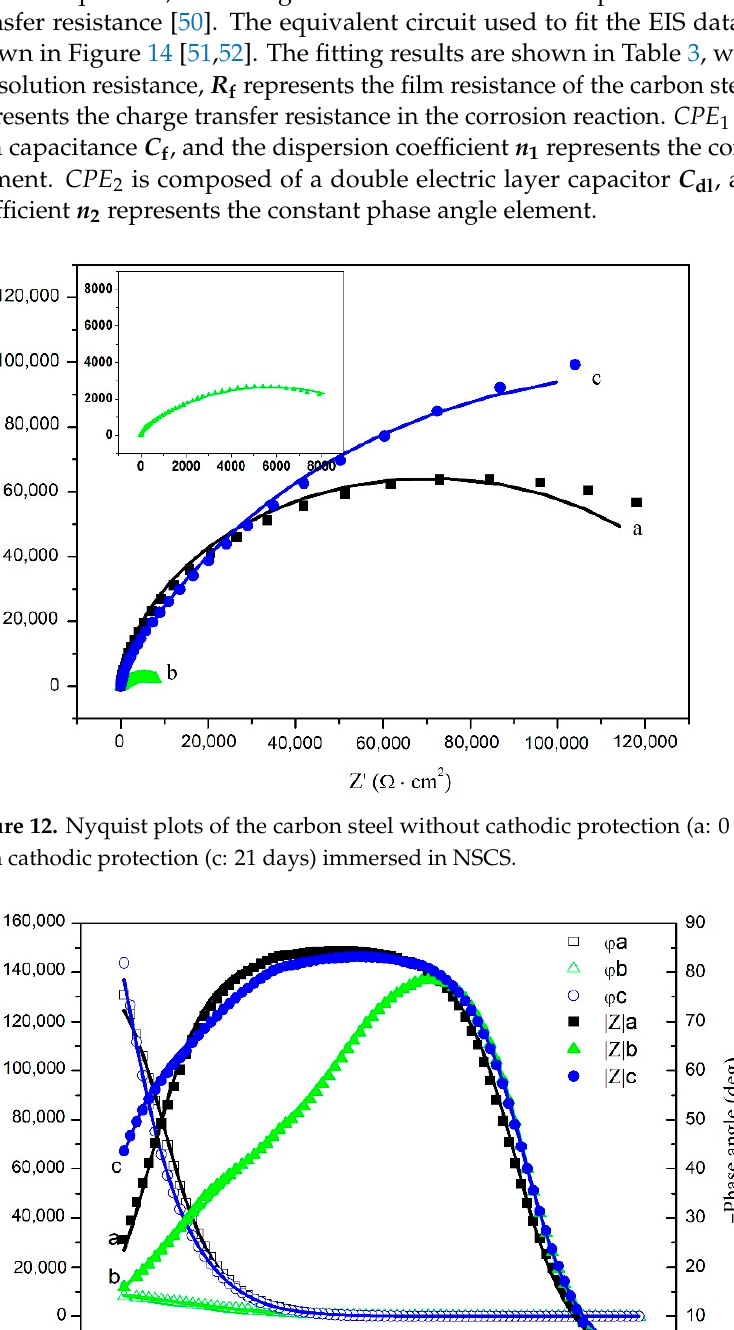
Figure 14. Equivalent circuit model used to fit EIS experiment data of carbon steel.